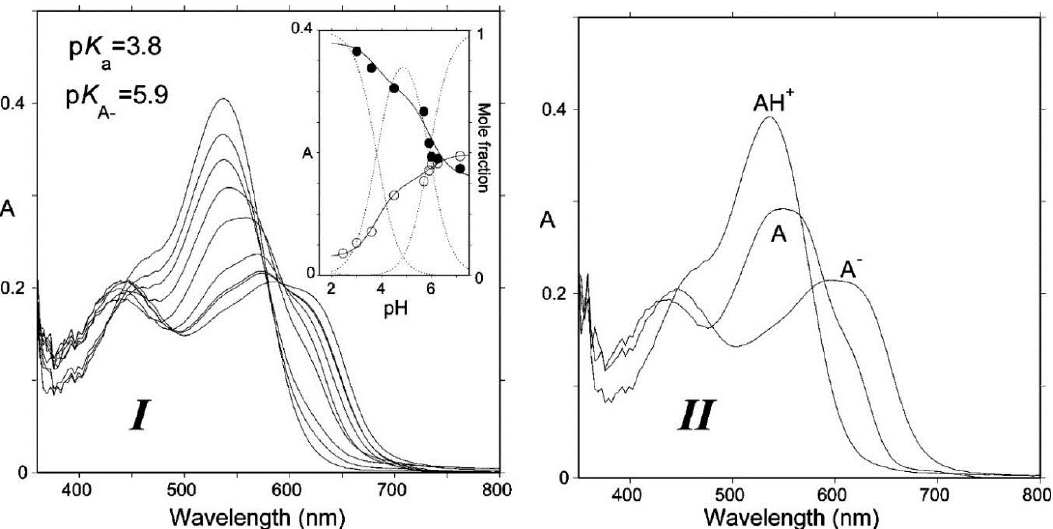
Figure 2. ( I ) Absorption spectra of Cat-Mv3Glc: pH jump from pH = 1.0 (100% flavylium) to pH 3.00, 3.59, 4.50, 5.70, 5.96, 6.25, and 7.15, respectively. Spectra recorded 10 ms after mixing (negligible water